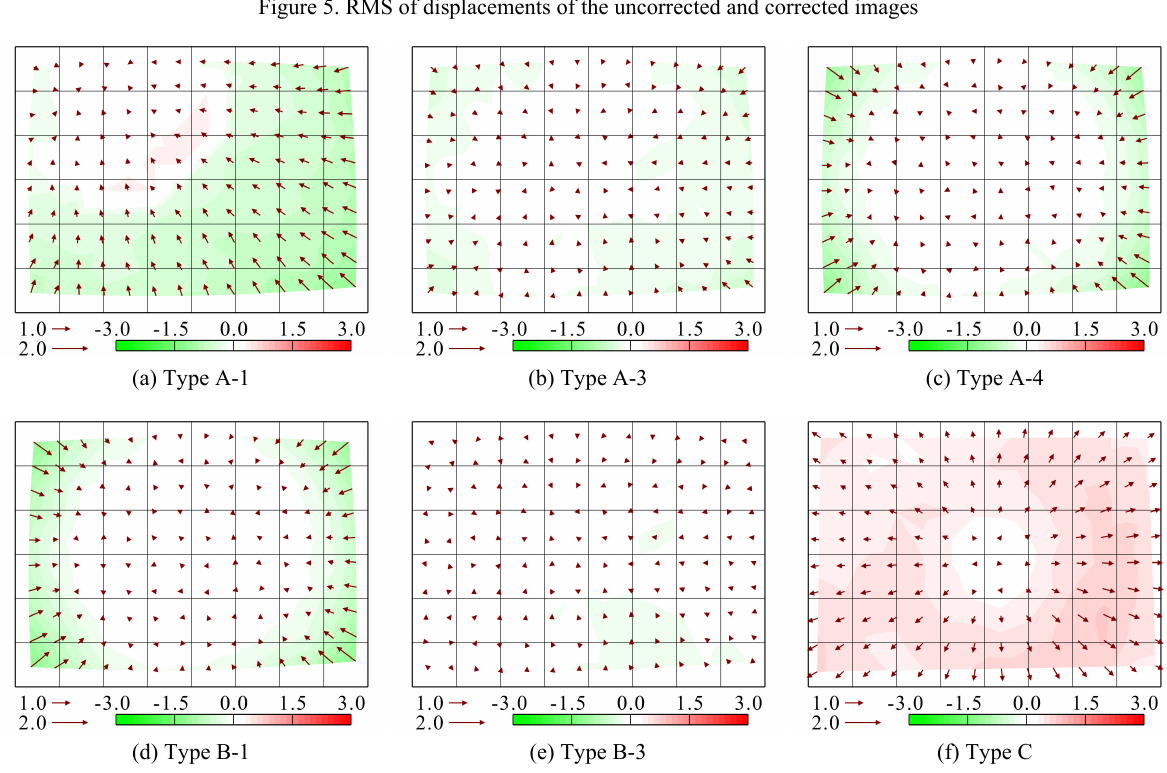
Figure 6. Displacement vectors G  R in the corrected image of the E-P2 (Unit: